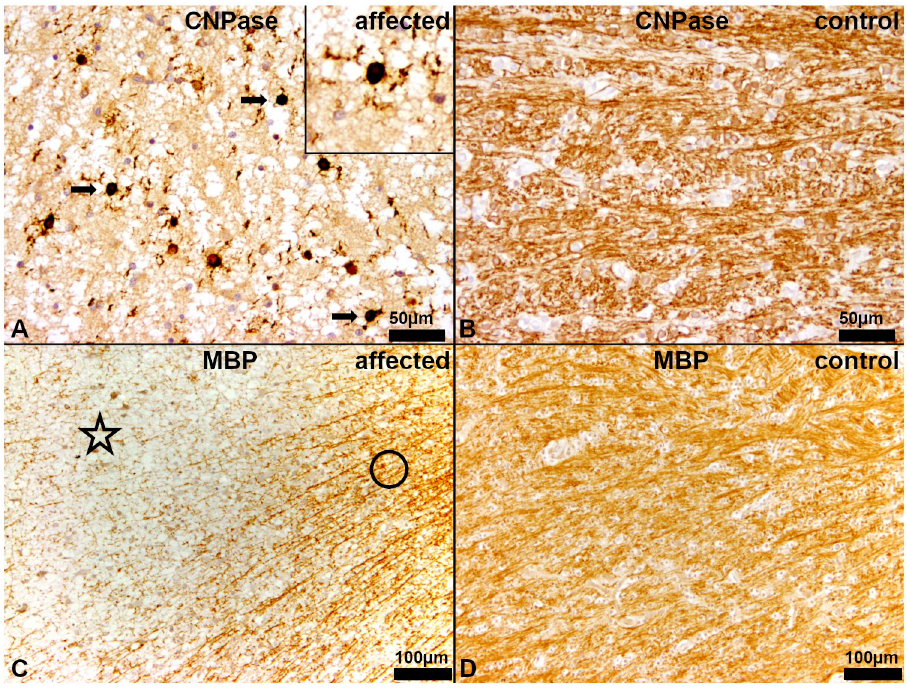
Fig 5. Immunohistochemistry of the white matter in the centrum semiovale of the cerebrum. (A, C) Affected puppy no. 1 and (B, D) age matched healthy control no. 1009. (A) In affected puppies almost no myelin is detectable whereas oligodendrocytes show fragmented processes and a strongly perinuclear cytoplasmic positive signal (arrows). Inset shows an oligodendrocyte with strong perinuclear cytoplasmic signal in a higher magnification. (CNPase). (B) In age matched controls the white matter shows a marked, diffuse brownish staining of the myelin. (CNPase). (C) Only single, fine strands of myelin (asterisk) were detected in contrast to the dense meshwork of myelin in adjacent non- affected areas (circle) of diseased puppies. (MBP). (D) Age matched control puppies show a diffuse staining of the myelin of the white matter (MBP).